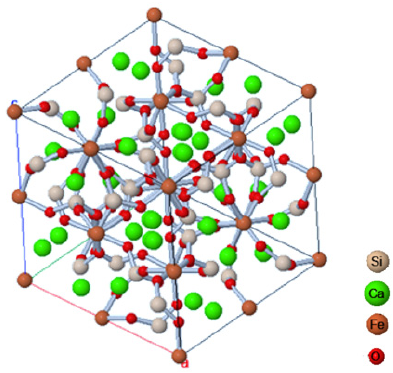
Figure 1. Crystal structure of garnet [2].